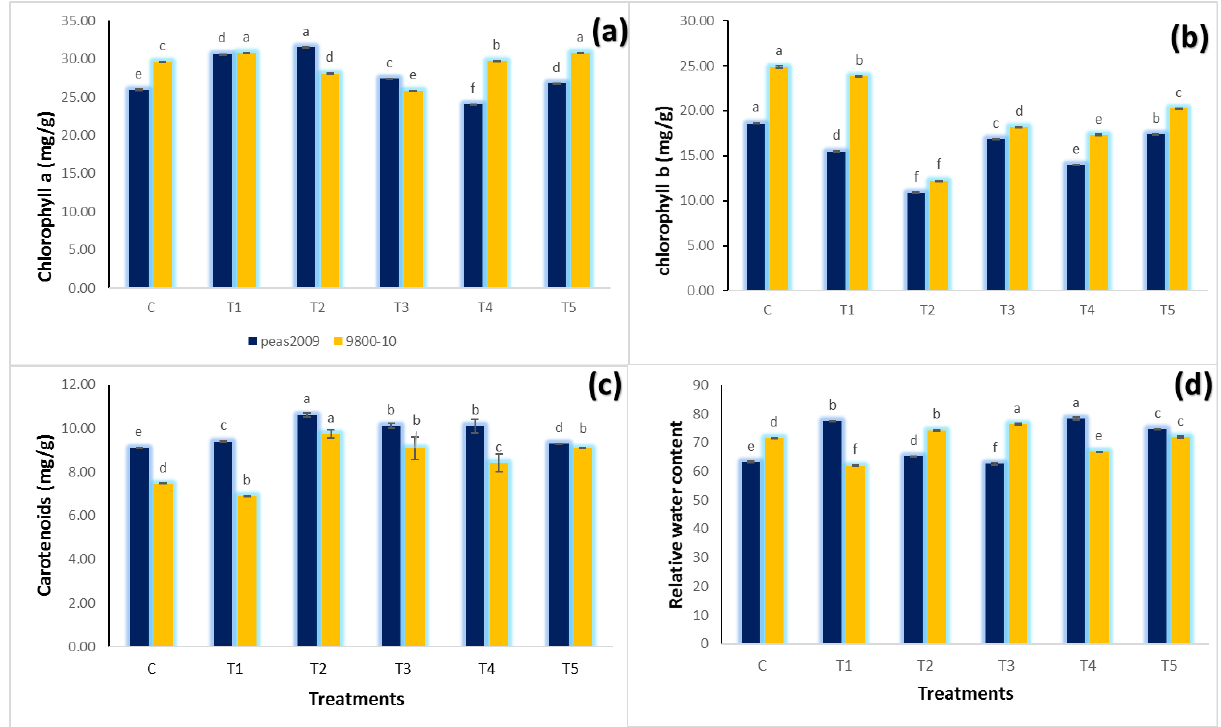
Figure 2. Effect of K. rhziophilla 14asp on electrolyte leakage ( a ) chlorophyll a, ( b ) chlorophyll b, ( c ) carotenoids, and ( d ) relative water content (RWC) in leaves of pea plants under a saline regime. Each treatment is presented as mean values of triplicate data ( n = 3) with standard error (S.E). C represents uninoculated control, T1 (75 mM NaCl), T2 (150 mM NaCl), T3 (inoculated with K. rhizophila ), T4 (75 mM NaCl + K.rhizophila ), and T5 (150 mM NaCl + K.rhizophila ). Different letters on means of treatment shows significant difference at p < 0.05.